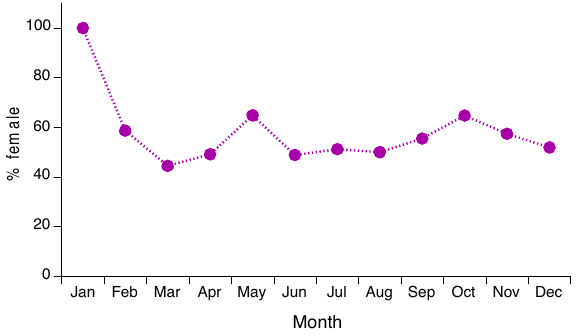
Figure 2. Sex ratio (proportion of snakes that were female) in samples of the Asian bockadam ( Cerberus schneiderii ) examined at processing facilities near the city of Cirebon in West